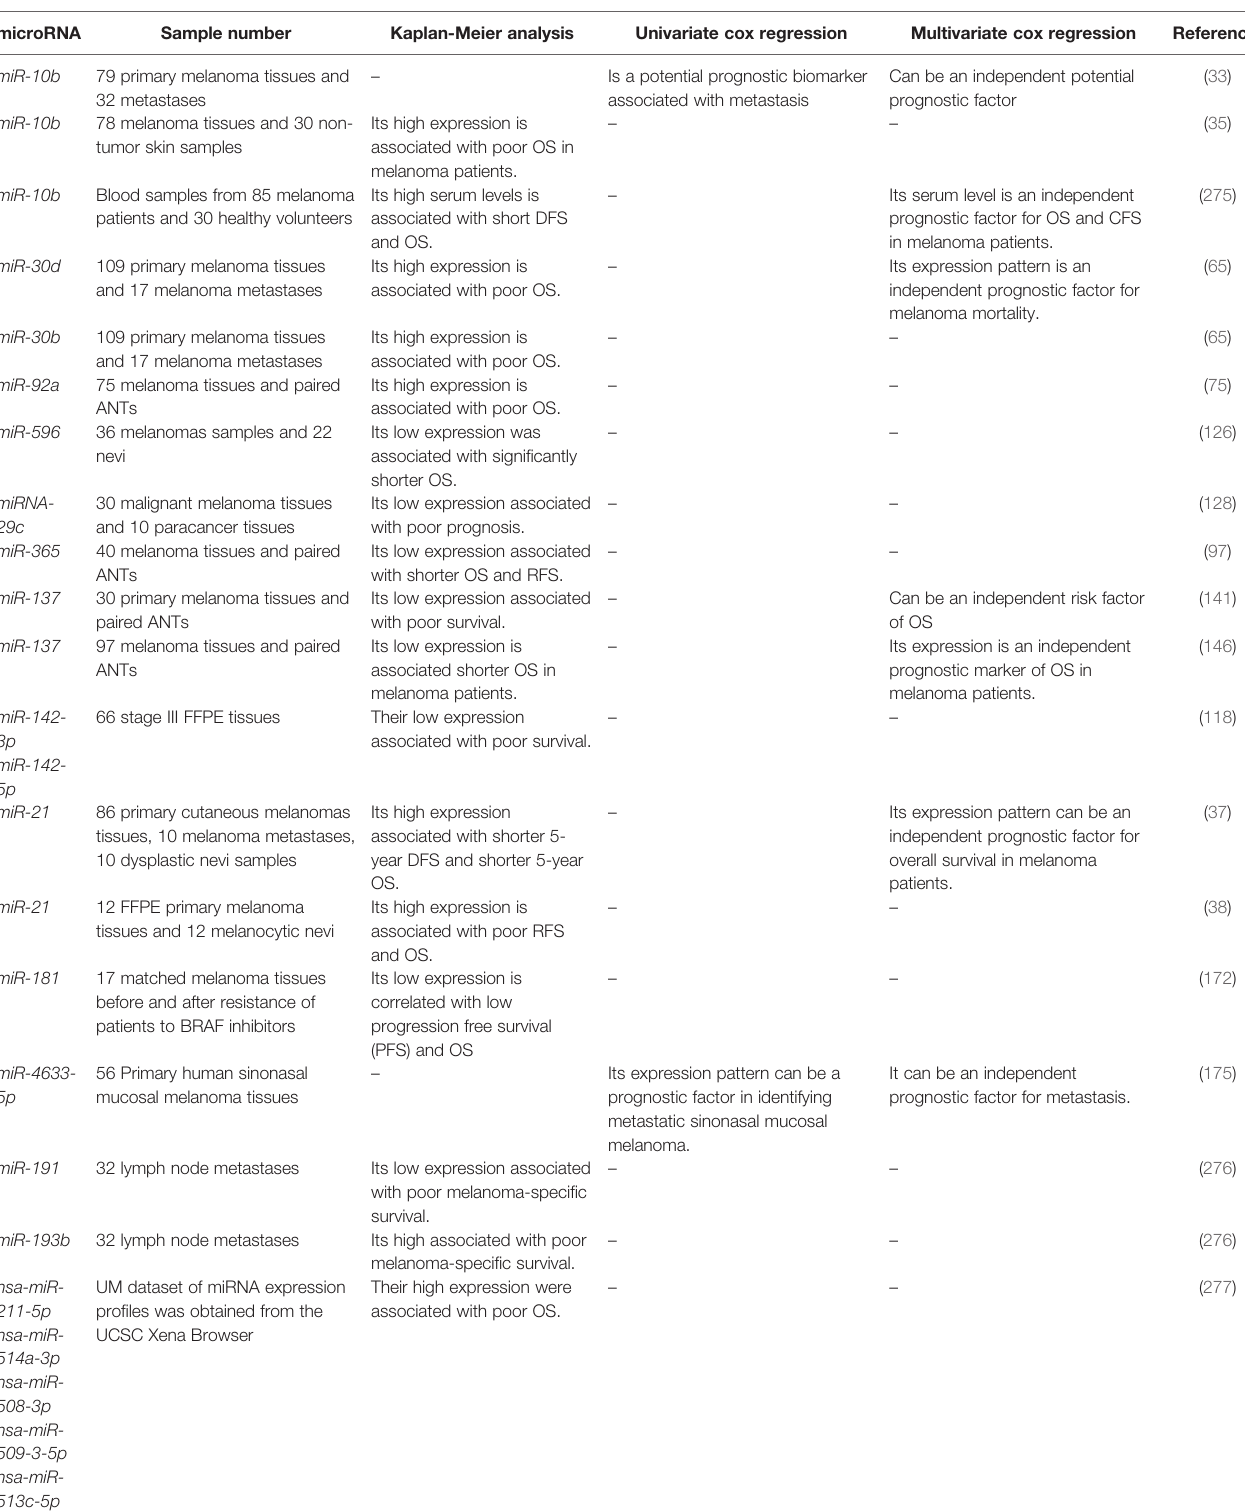
TABLE 3 | Role of melanoma in prediction of prognosis of melanoma (DMFS, distant metastasis free survival; OS, overall survival; DFS, disease-free survival; RFS, relapse-free survival; MSS, melanoma speci fi c